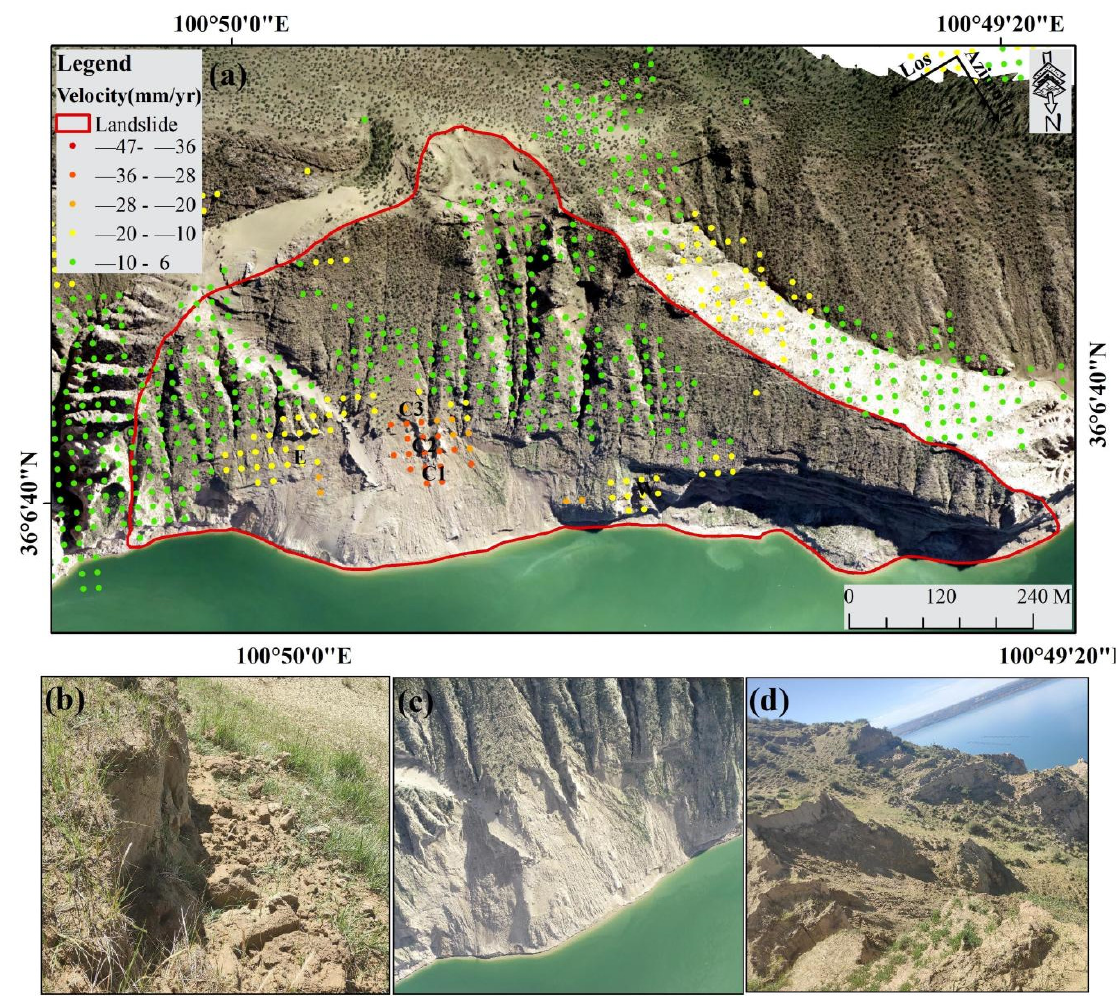
Figure 14. ( a ) Deformation velocity of Chaxi landslide, ( b ) partial collapse of the rear edge, ( c ) small landslides in the center, and ( d ) exposed soil in the western